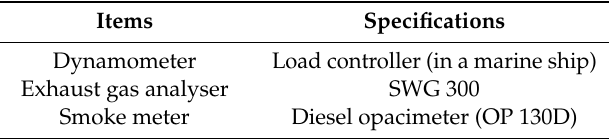
Table 2. Exhaust gas instruments.